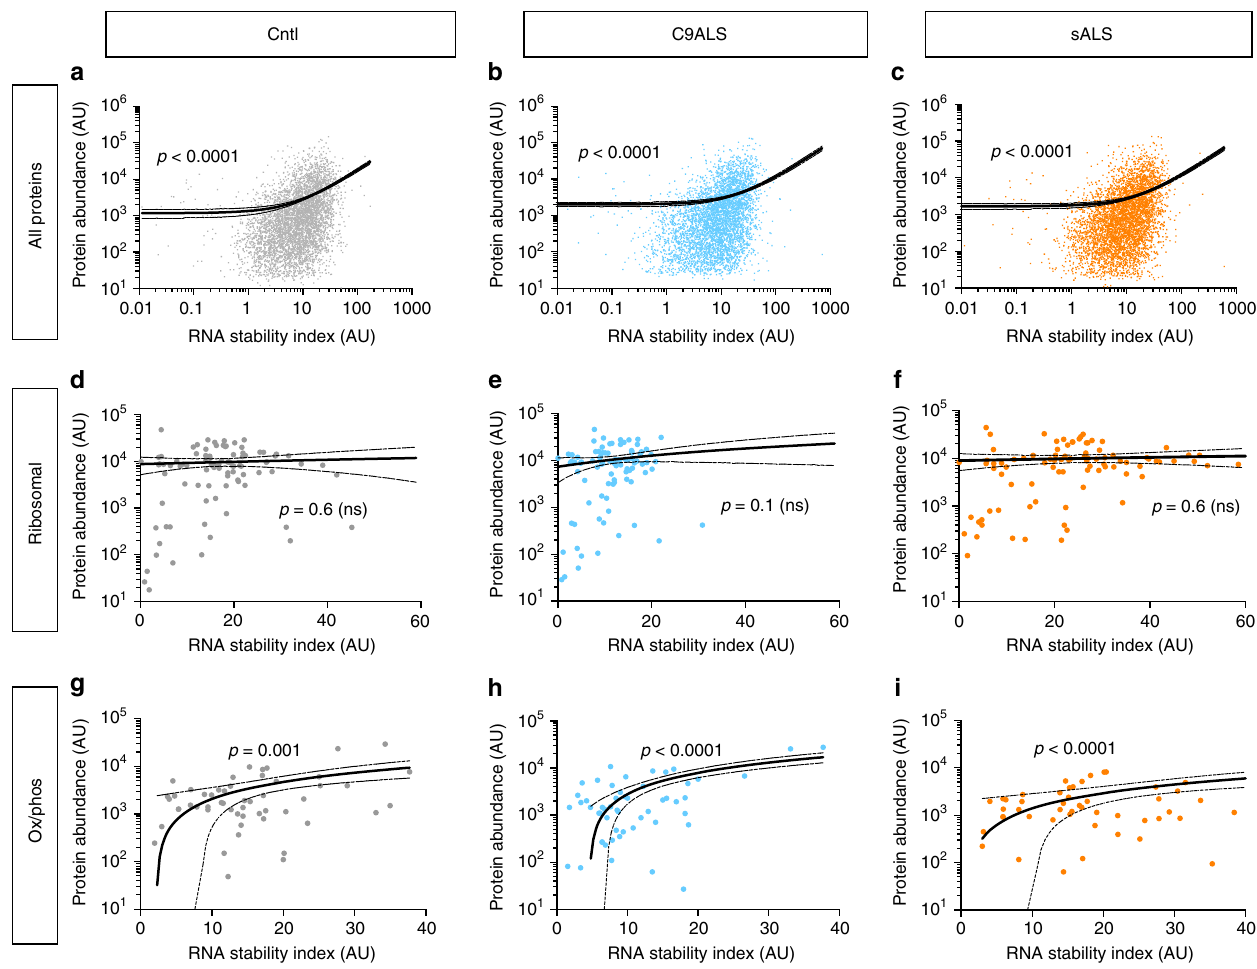
Fig. 7 Correlating RNA stability and protein abundance in ALS iPSCs. Linear regression of RNA stability (as measured by the RNA stability index for each transcript, or the abundance at 6 h/0.5 h) and protein abundance determined by MS. A signi fi cant ( p < 0.0001) association was detected between RNA stability and protein abundance in control, C9ALS and sALS iPSCs for all transcripts (top row, a − c ) and for those involved in oxidative phosphorylation (Ox/phos, bottom row, g − i ). However, no such relationship was identi fi ed for ribosomal protein-encoding transcripts and their corresponding proteins (middle row, d − f ). Representative scatter plots are shown from one line each of control, C9ALS and sALS iPSCs; identical results were obtained upon examination of other lines. p value determined by extra sum-of-squares F test NATURE COMMUNICATIONS| (2018) 9:2845 |DOI: